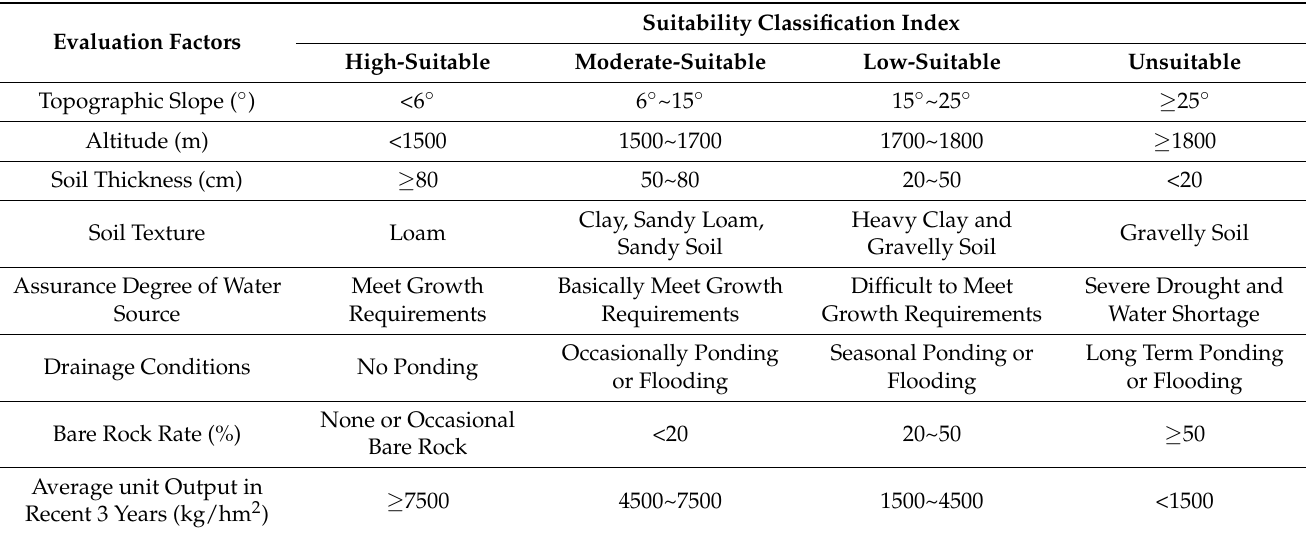
Table 1. Evaluation factors and grading indexes of land suitability evaluation of sorghum